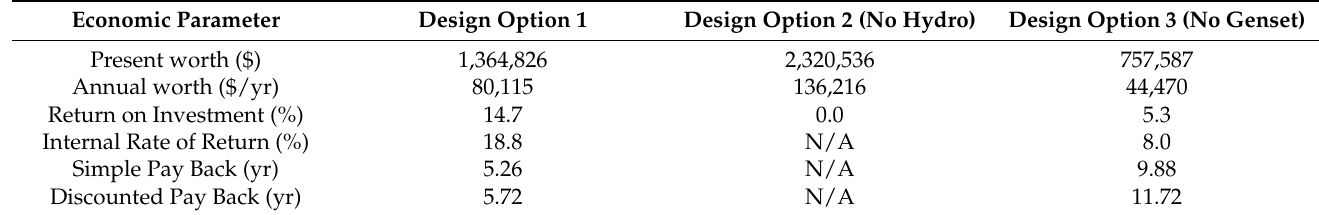
Table 12. Comparison of economic parameters.